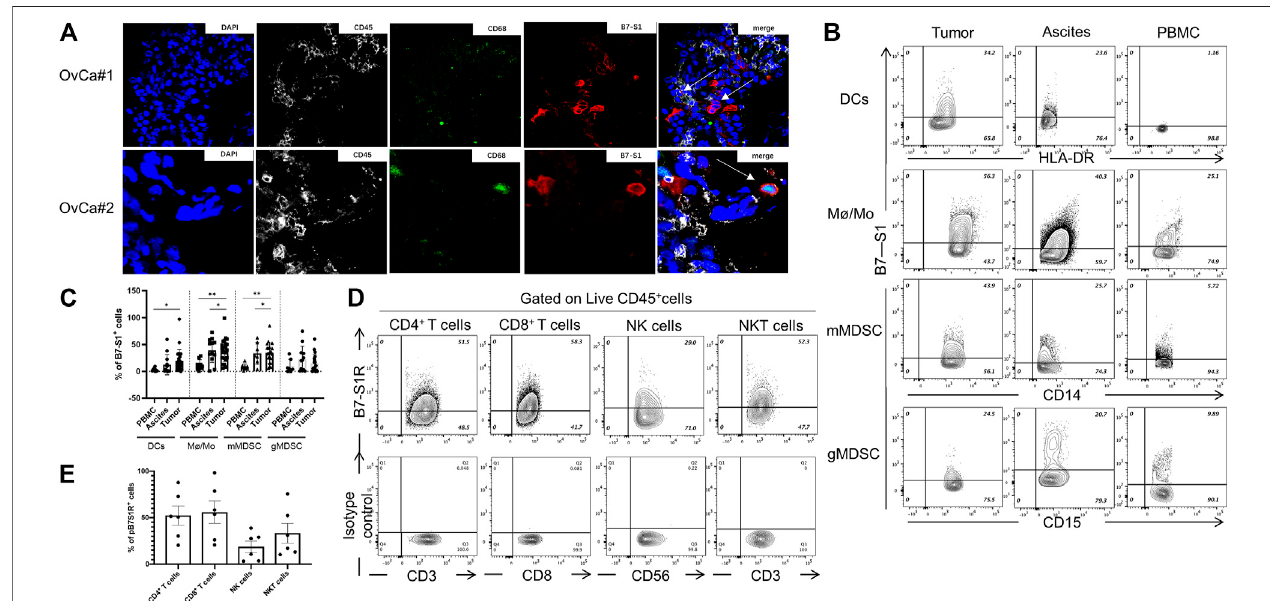
FIGURE 2 | B7S1 protein was mainly expressed in intratumoral myeloid cells in human OvCa. (A) Representative immuno fl uorescence images of B7S1 in human OvCa. Original magni fi cation: 40x (OvCa#1), 100x(OvCa#2). (B,C) Representative fi gures and summarized data showing the percentages of B7S1-positive DCs, Mø/ Mo,mMDSCs, andgMDSCsintumors,ascites,andPBMCsfrompatientswithOvCa.Statisticalanalysiswasperformedusingone-wayanalysisofvariancefollowedby Tukey ’ s multiple comparison tests. The data are presented as means ± standard errors of the means; ns P > 0.05, * p < 0.05, ** p < 0.01, and *** p < 0.001. (D,E)